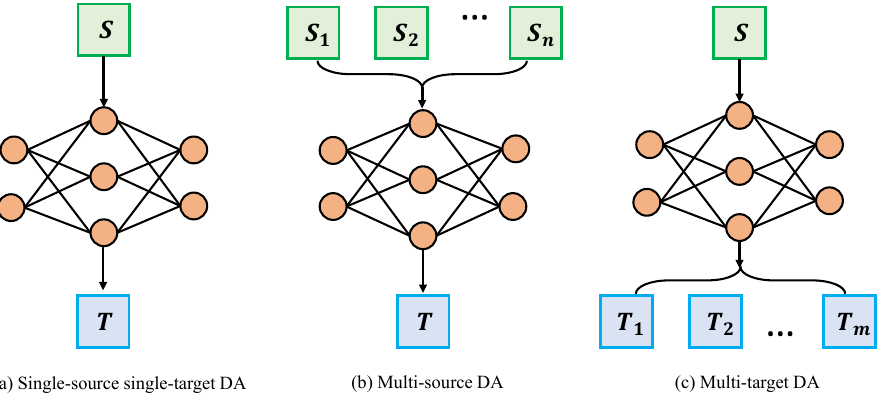
Figure 11. Different adaptation settings. S and T denote the source and target domains, respec- tively. S 1 , S 2 , · · · , S n and T 1 , T 2 , · · · , T m denote n different source domains and m different target domains,